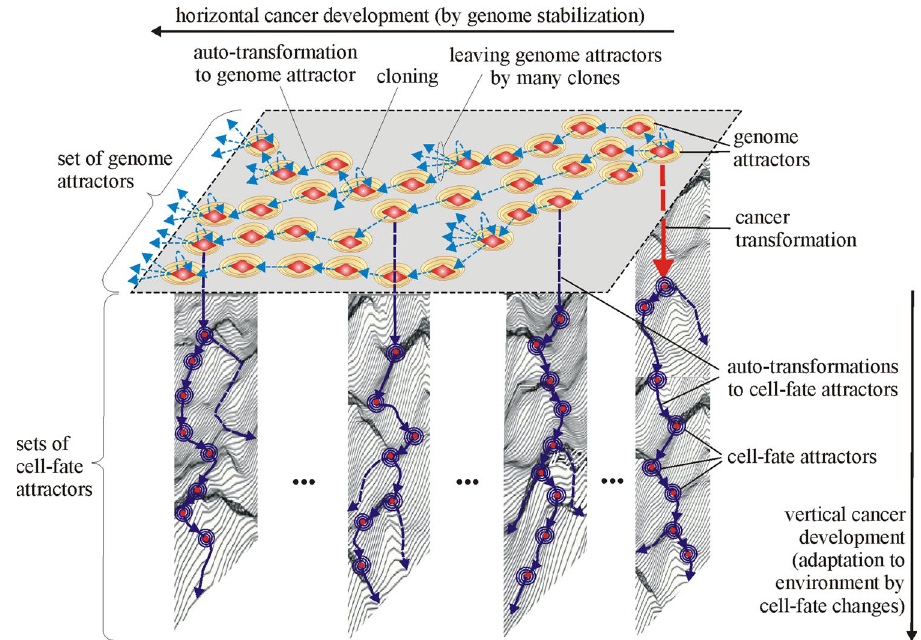
Figure 7. Horizontal and vertical cancer development in view of the new universal model of cancer transformation and cancer development. Cancer transformation activates, among others, cloning which causes that many clones can leave (because of occurrence of genome chaos) current genome attractor (GA) and attain new/different genome attractors by auto-transformation to genome attractor. The clones are kept alive after attaining new genome attractors by establishing appropriate new cell-fates. After attaining a new genome attractor, random mutations caused by elevated ROS level can lead to: ( a ) genome chaos occurrence and a change of genome attractor (macro-cellular evolution) or ( b ) destabilization of current cell-fate and a change of cell-fate attractor (micro-cellular evolution). Note: micro-cellular evolution can also occur without mutations, only as a result of cell-fate adaptation to changes in environment (vertical cancer development). It should be also noted that the figure shows only example sets of cell-fate attractors (as well as the presentation of the cloning process and leaving genome attractors by many clones are also limited to only a few cases) to ensure the clarity of this figure. In accordance with schemas of cancer development (Figs. 10, 11), vertical development occurs, among others, after each change of genome attractor.